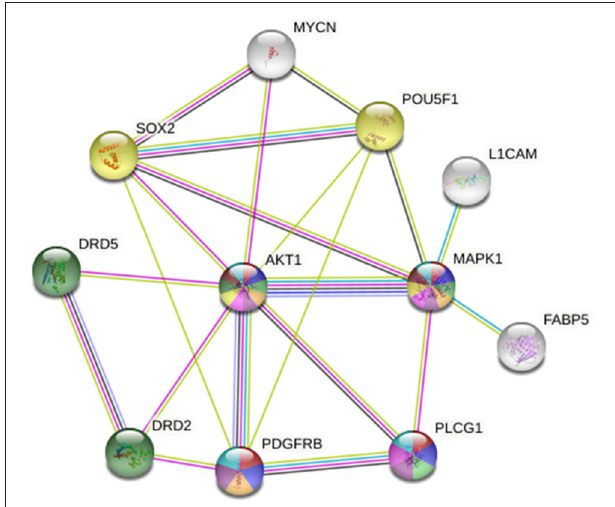
FIGURE 10 | STRING protein network analysis reveals an intricate interplay between the inhibitory targets of ONC201 and ONC206, DRD2/DRD5, and AKT/MAPK1, and other tumorigenic proteins implicated in cellular mechanisms of cancer progression, metastasis, and drug resistance. This protein interaction visualization demonstrates the complex interplay between AKT, MAPK, and many other proteins including PDGFR β , Sox-2, Oct-4, MYCN, FABP5, and L1CAM that play key roles in tumor initiation, progression, metastasis, recurrence, and cancer stem-cell maintenance. The sources of these interactions are derived from experimental results (pink lines), curated databases (blue lines), gene co-expression (black lines), gene co-occurrence (dark blue lines), and text mining (green